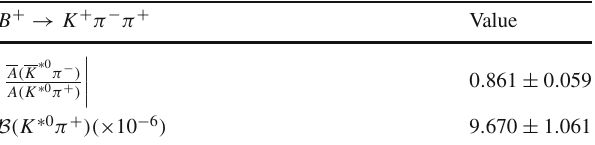
Table 8 Central values of the observables from the Belle B + →